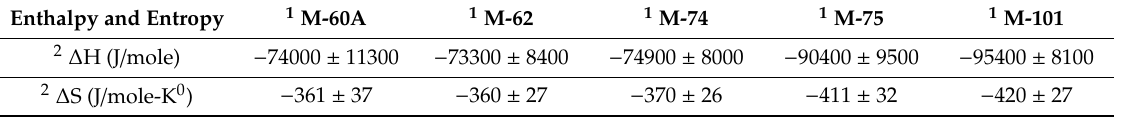
Figure 12. Ascending and descending pH profiles for M-101 particles at 23 and 37 °C. Solid line = ascending pH profile. Dashed line = descending pH profile. Table 9. ∆ H and ∆ S of pH-Induced Swelling of N -isopropylacrylamide Copolymers of Propacrylic Acid.